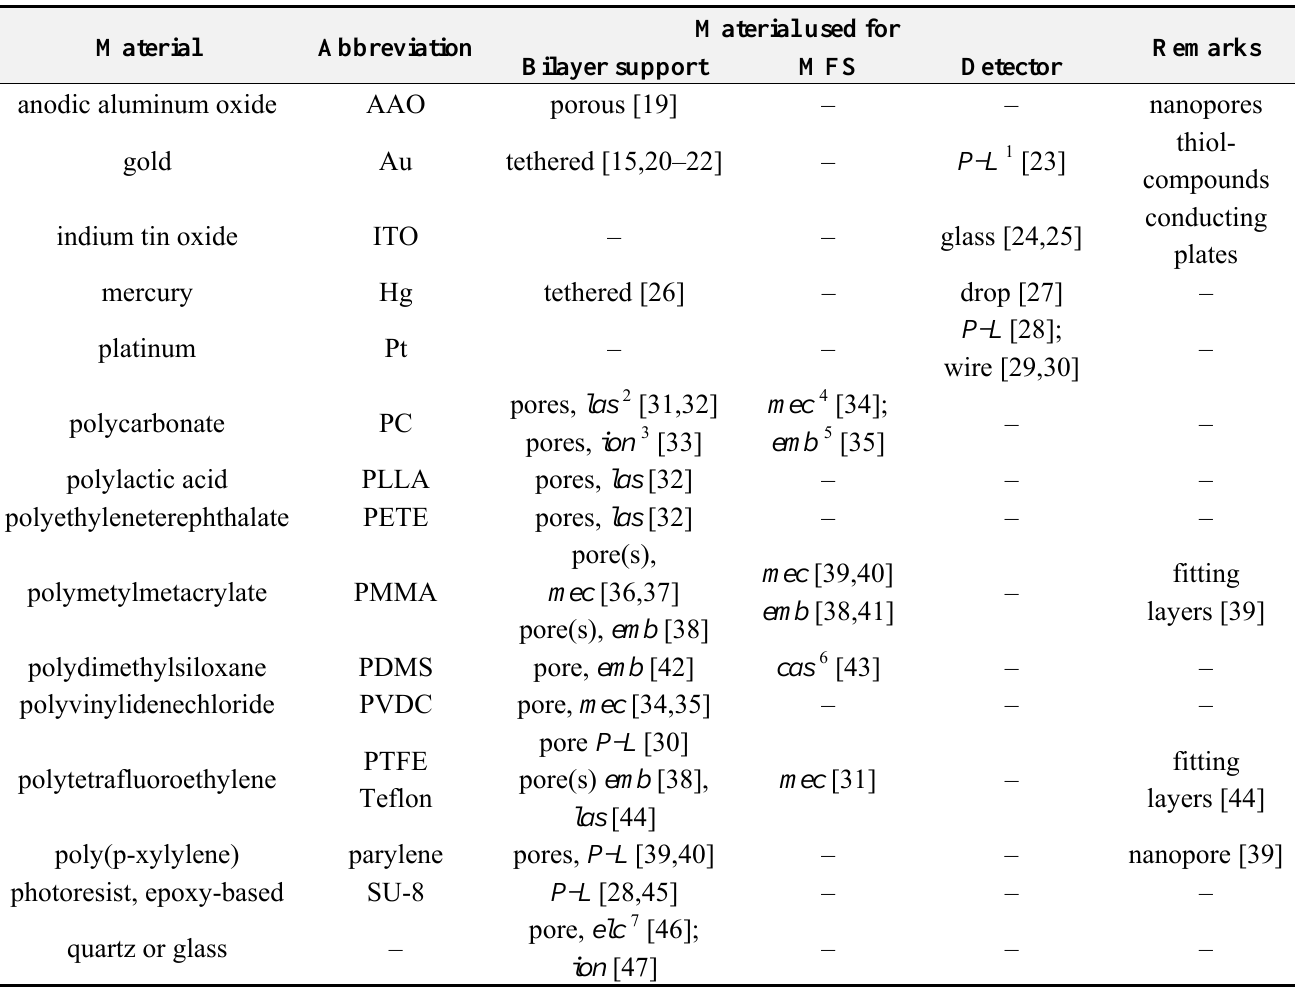
Table 1. Materials used in biosensors of membrane